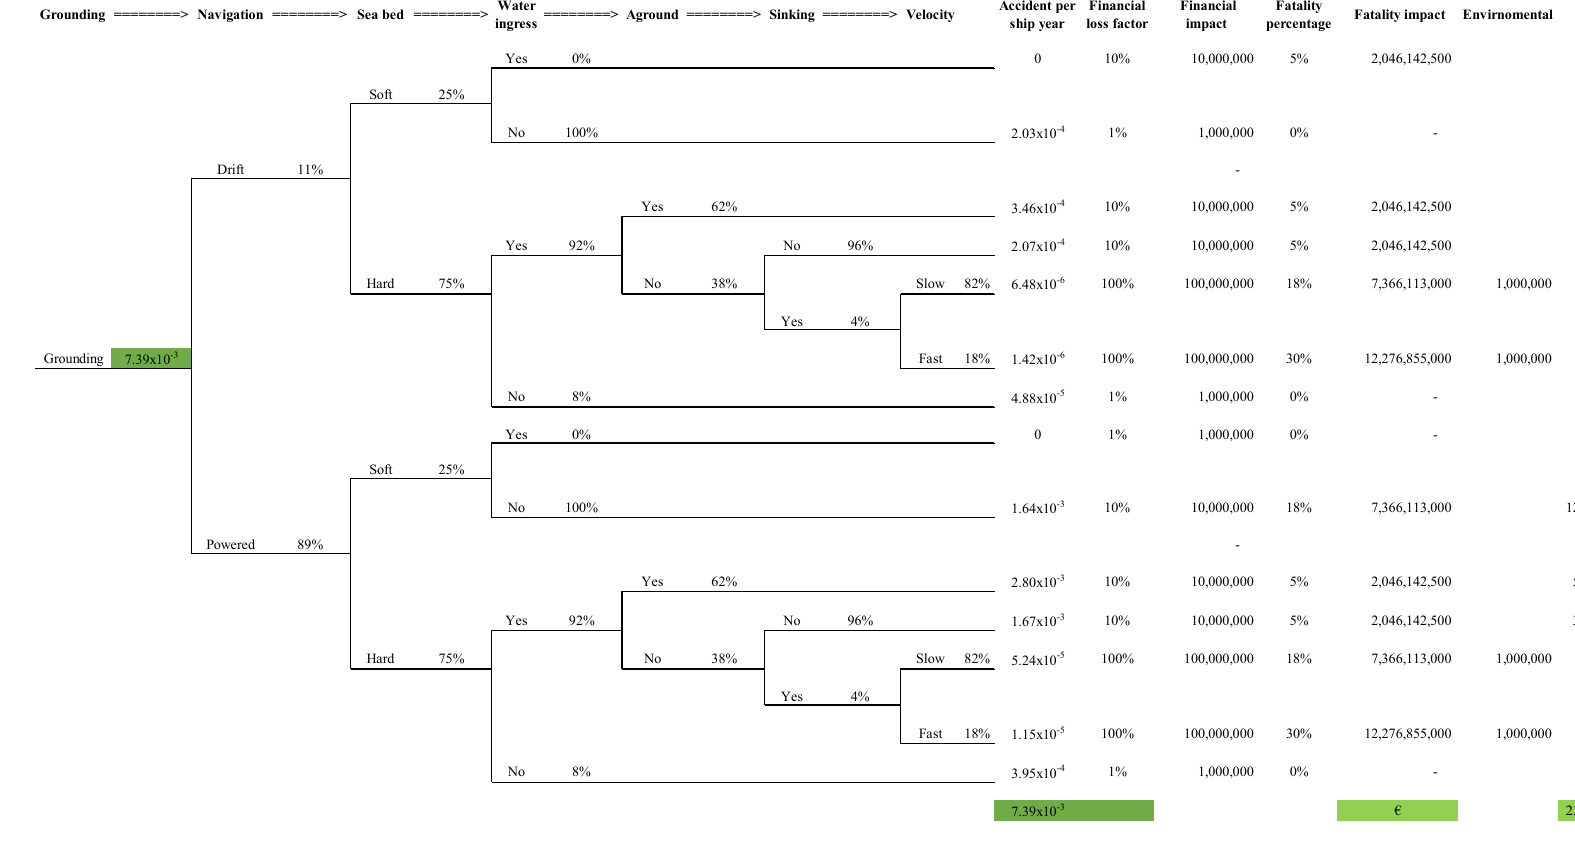
Figure 13. Event tree analysis of grounding for passenger ships.